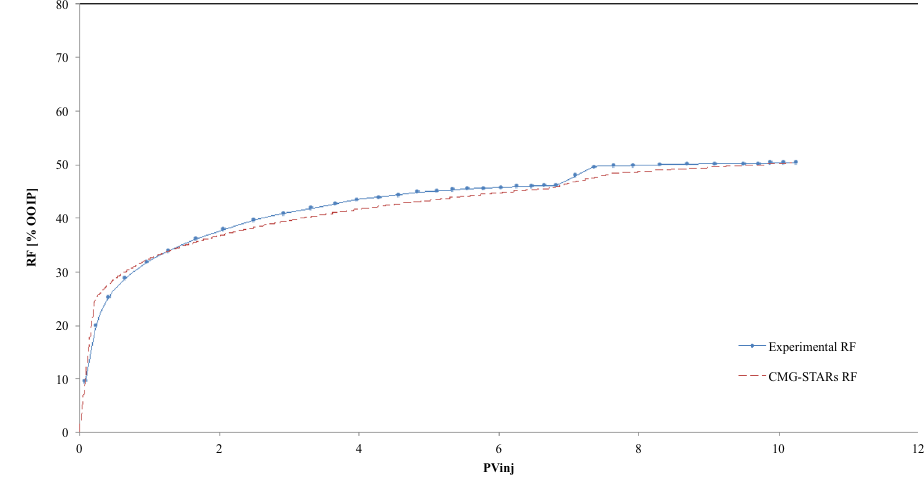
Fig. 14 History matching